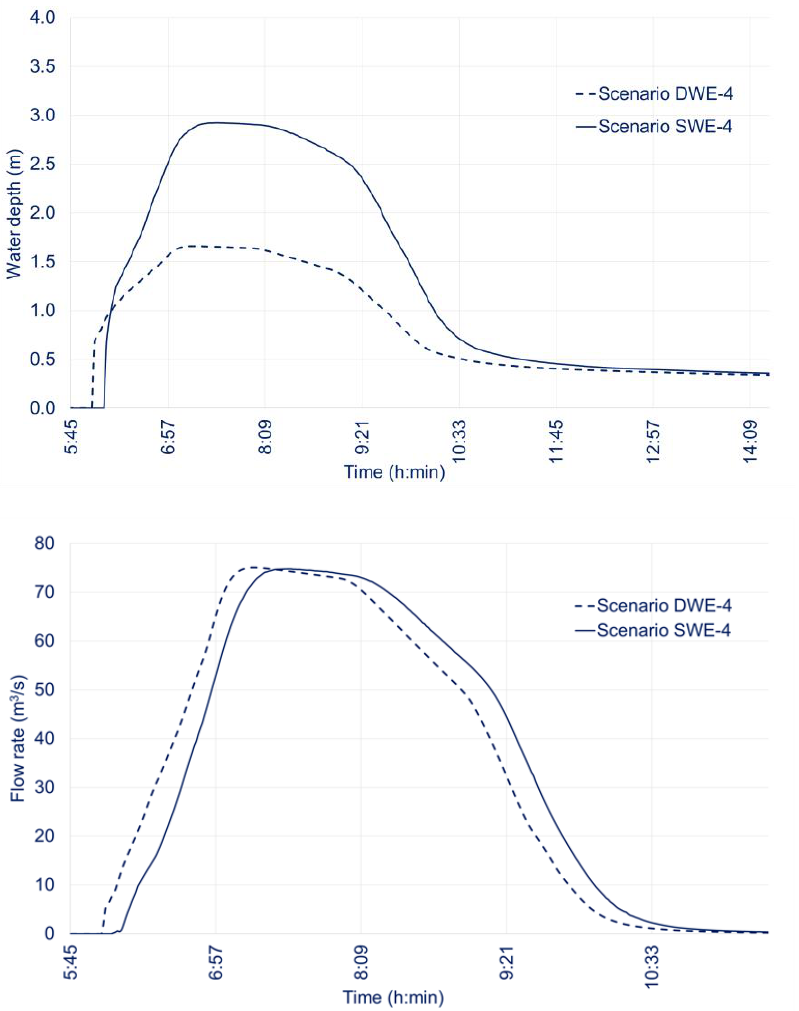
Figure 7. Comparison of hydrographs for the water depth and flow rate in the cross-section that passes through the monitoring location L5.